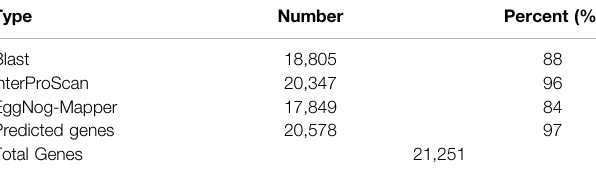
TABLE 4 | Summary statistics of functional annotated protein-coding